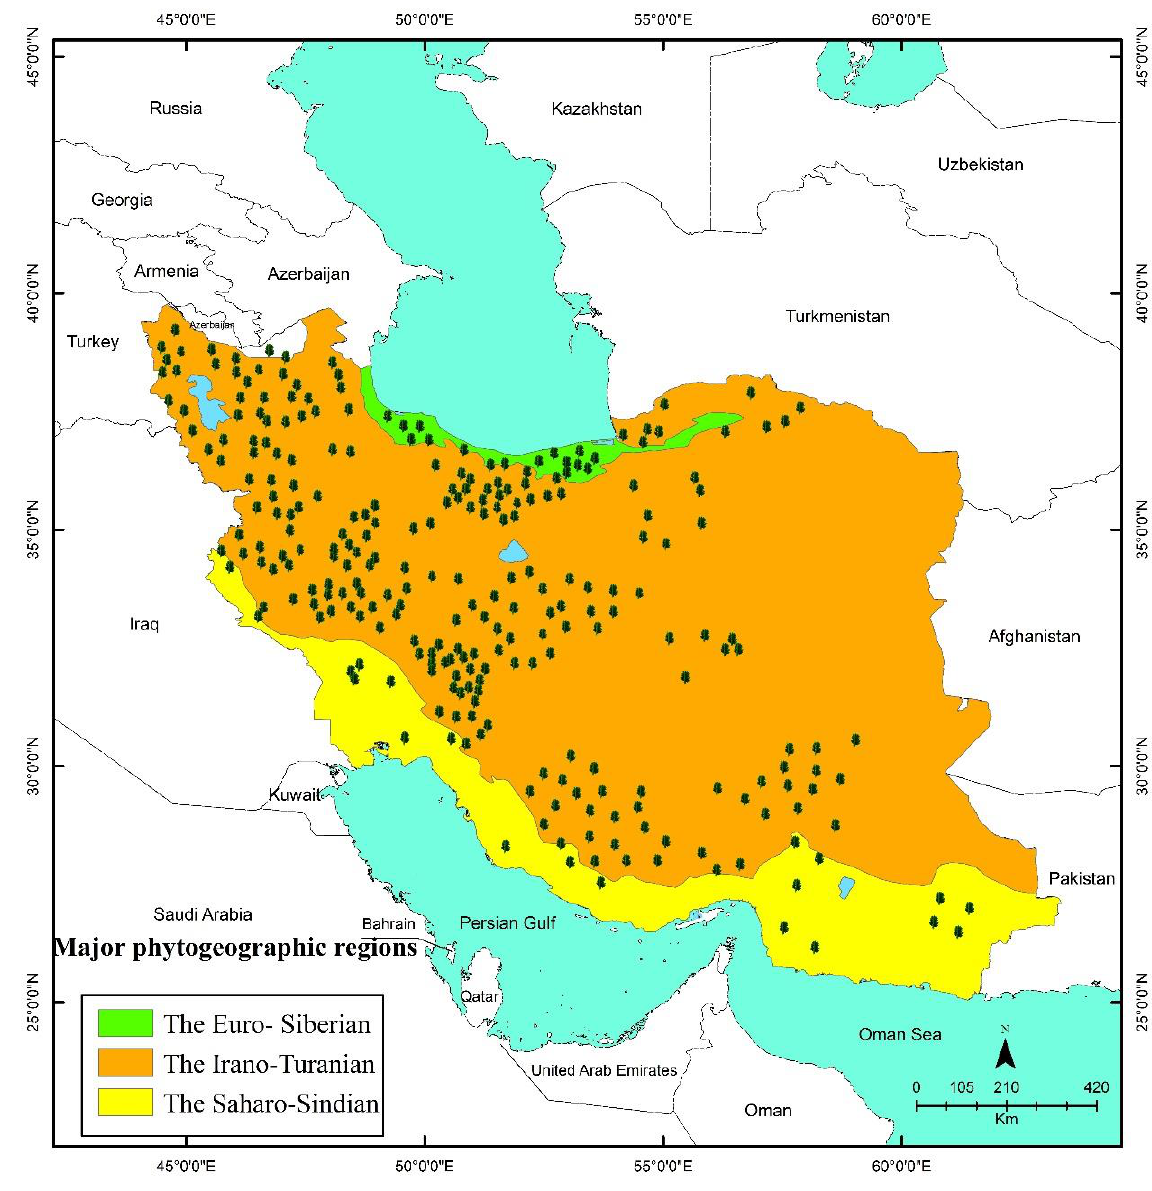
Figure 6. Topogeographic map of Iran indicating phytogeographical regions and distribution of endemic medicinal and aromatic plants.